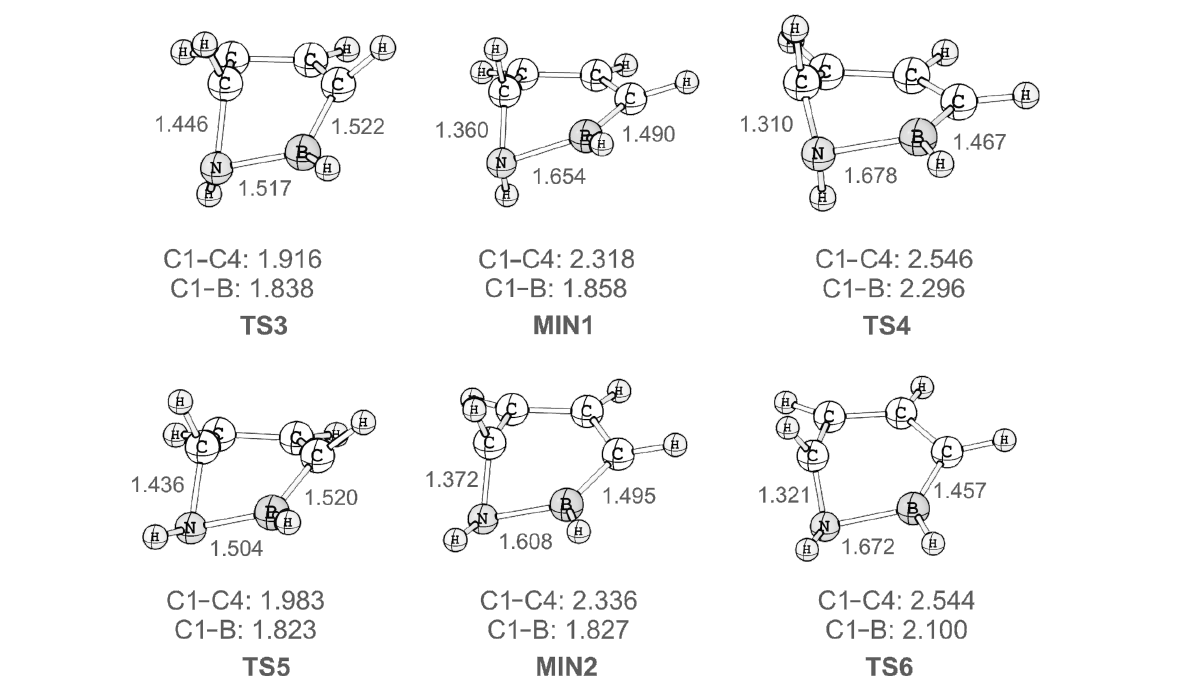
Figure 3: Geometries of MIN1 , TS3 , TS4 and MIN2 , TS5 , TS6 computed at the CCSD(T)/TZ2P level of theory. C1–N, N–B, C4–B, C1–C4, and C1–B distances are given in angstroms (Å).